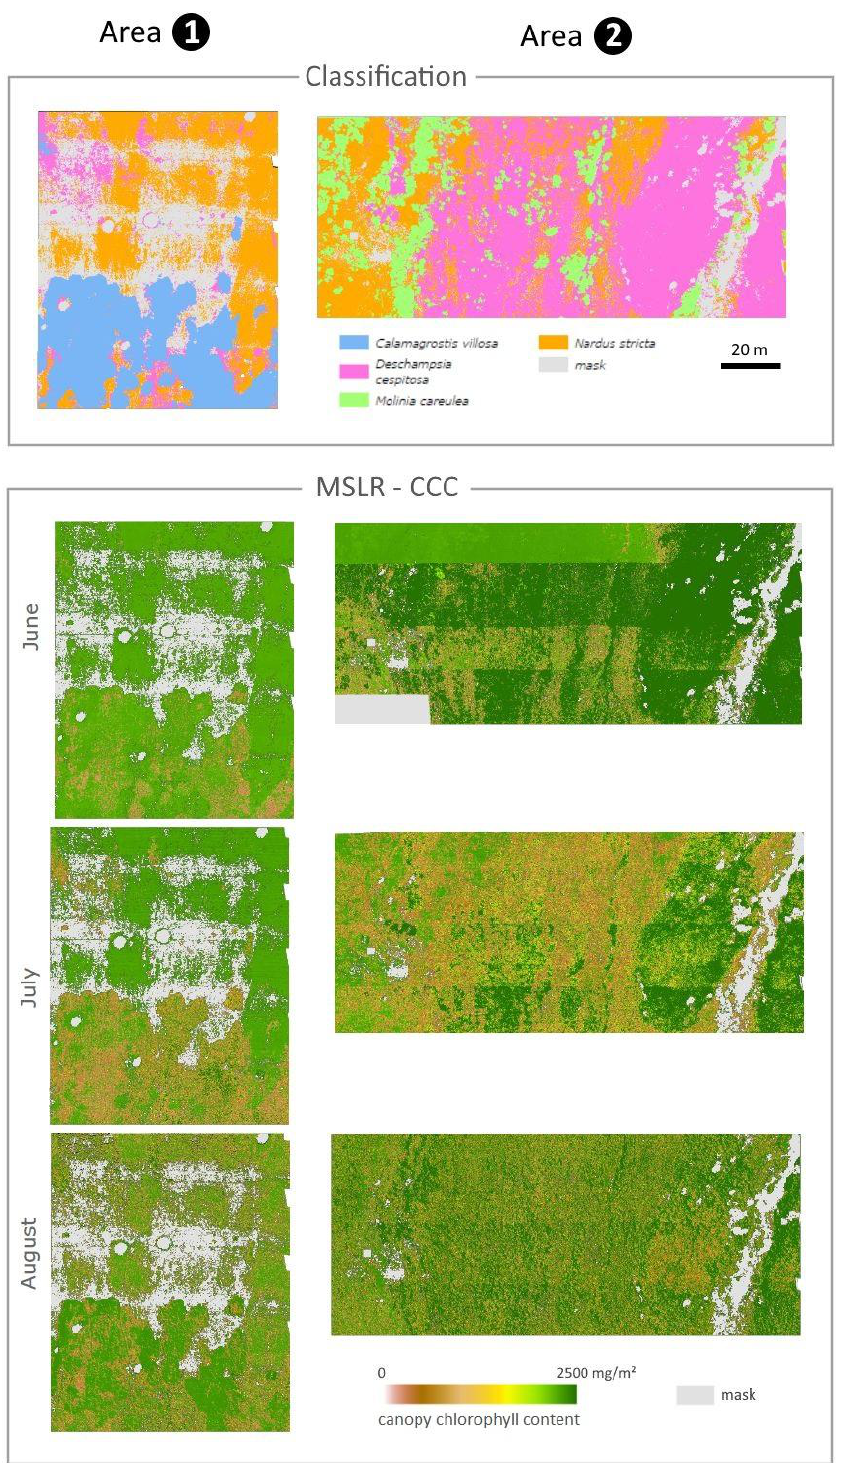
Figure 6. The species classification and the canopy chlorophyll content (CCC) map based on the stepwise multiple linear regression (MSLR - Equation 1) computed for the image